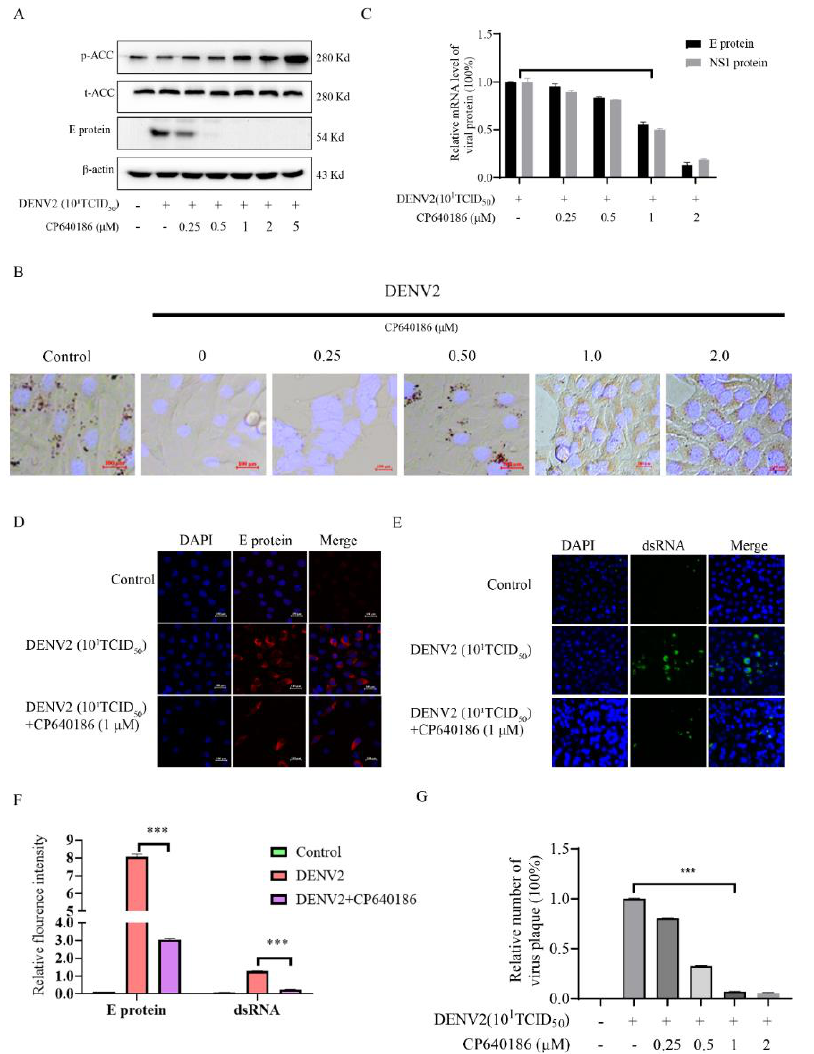
Figure 2. The relationship between ACC phosphorylation and DENV2 infection. After DENV2 infection of BHK-21 cells for 1 h, CP640186 was added at indicated concentrations and incubated for 48 h. ( A ) The levels of p-ACC, T-ACC, viral E protein, and GAPDH were analyzed by Western blotting. ( B ) The cellular lipid droplet was observed under microscope after oil red staining. ( C ) The mRNA levels of viral E protein and NS3 protein were analyzed by RT-qPCR assay. ( D ) The levels of viral E protein and ( E ) the levels of viral dsRNA were observed under confocal microscopy. ( F ) The quantification results of ( E , F ). ( G ) The number of progeny viruses in the supernatant was qualified by plaque assay. Each experiment was repeated 3 times and column data represent mean ± SD. *** indicates p < 0.001.